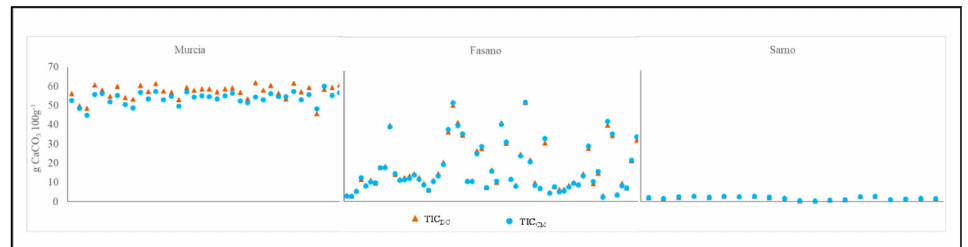
Figure 1. Comparison of soil inorganic carbon content detected by dry combustion (TIC DC ) and calcimeter methods (TIC CM ), per experimental site. Data set consisted of 117 samples: 36 from Murcia, 61 from Fasano, and 20 from Sarno.